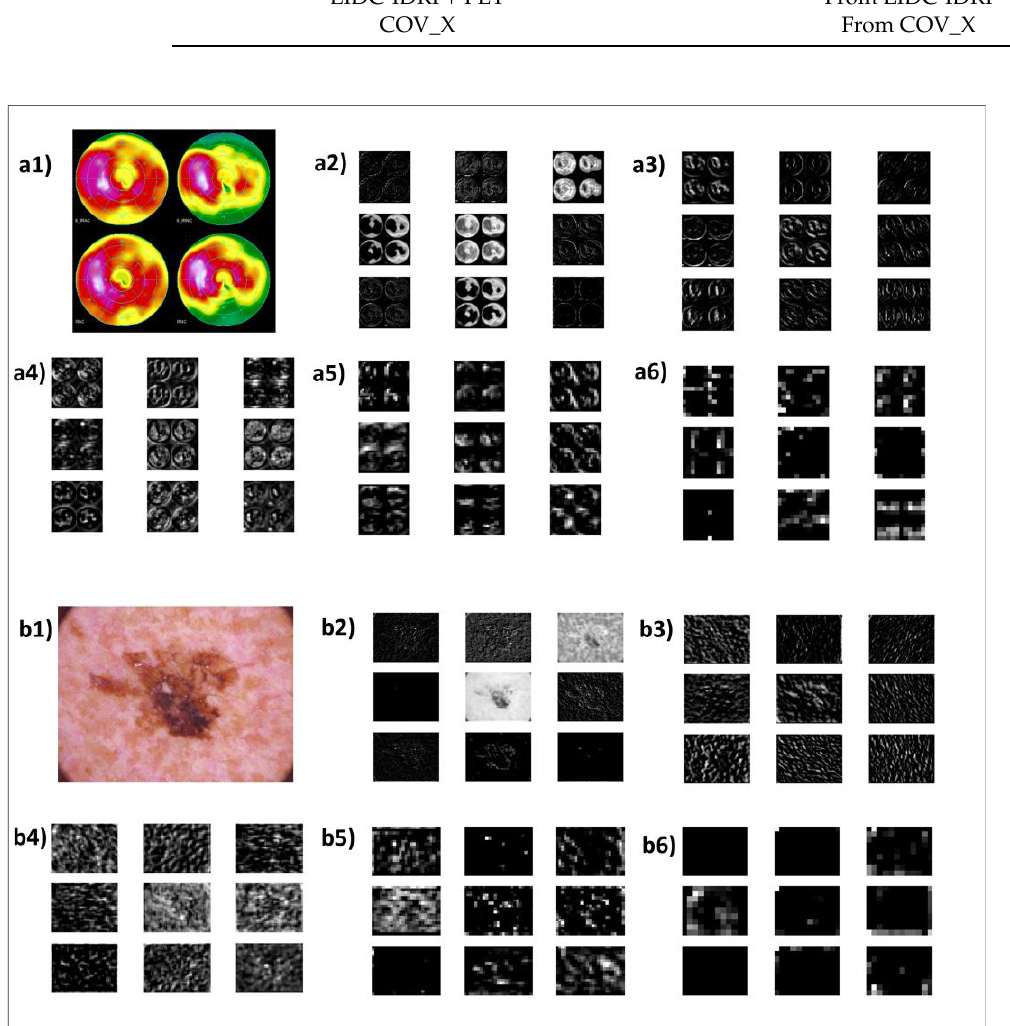
Figure 6. FF-VGG19 extracted feature maps of a random input image, where ( a1 – a6 ) refer to feature maps from the MPIP dataset, and ( b1 – b6 ) refer to features maps from the MNIST + SKIN + NVLES dataset.